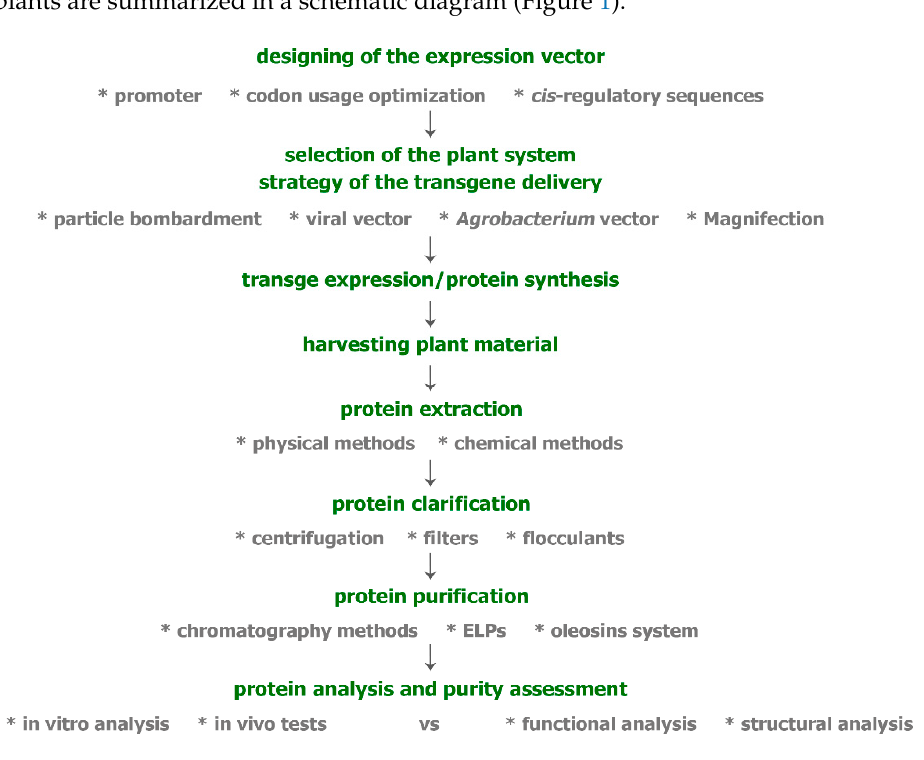
Figure 1. Schematic diagram of the production of biopharmaceuticals in transgenic plants.